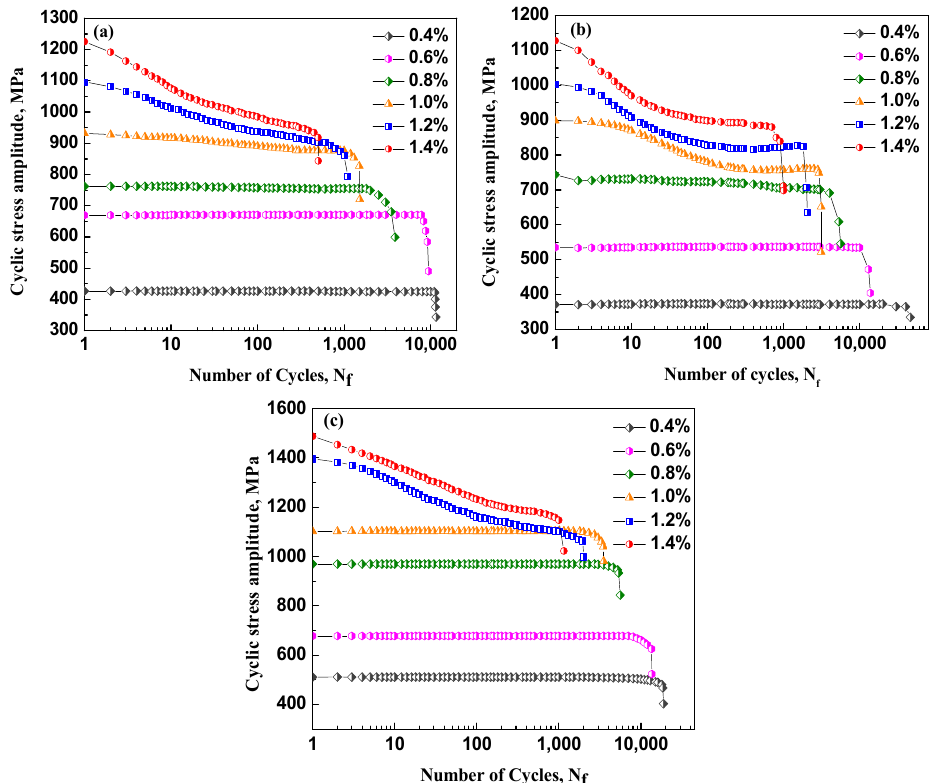
Figure 3. Cyclic stress response curves of the alloy after aging treatment. ( a ) 4 h, ( b ) 12 h ( c ) 24 h. (a) At low total strain amplitude (alloys aging for 4 h and 24 h: ∆ ε / 2 ≤ 1.0%, alloy aging for 12 h: ∆ ε / 2 ≤ 0.8%), cyclic saturation was exhibited, followed by a short stage of softening. (b) At high total strain amplitude (alloys aging for 4 h and 24 h: ∆ ε / 2 > 1.0%, alloy aging for 12 h: ∆ ε / 2 > 0.8%), the alloy generally exhibited a rapid cyclic softening. It is worth mentioning that, for the alloy aging for 12 h at ∆ ε / 2 ≥ 1.0%, cyclic saturation stage after the initial softening was reached